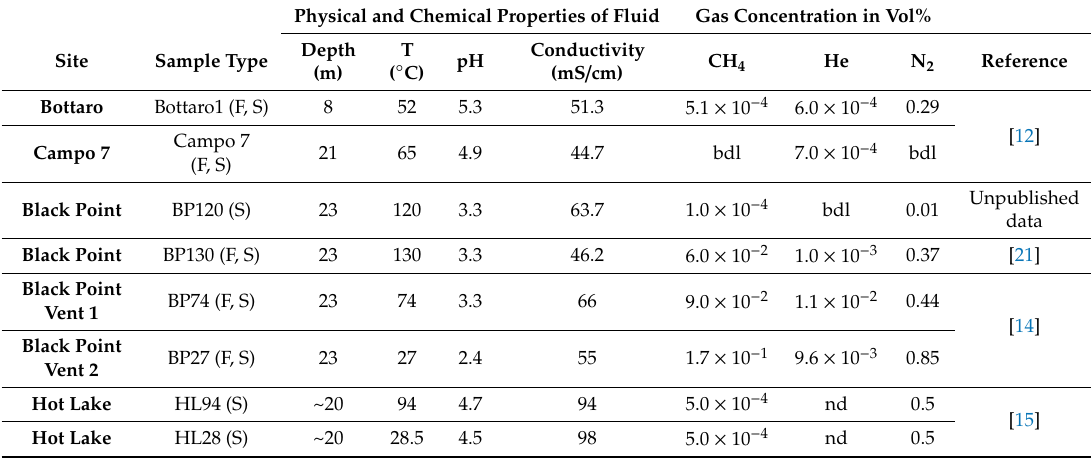
Table 3. Analytical data of hydrothermal fluids emitted from vents of Panarea Island and collected sample type (F: fluid and S: